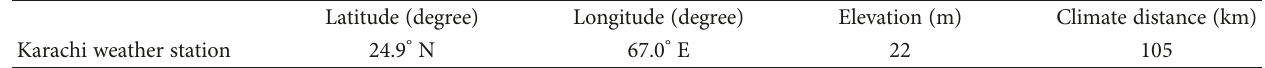
Table 4: The coordinates of the Meteonorm stations and climatic distance to the site.